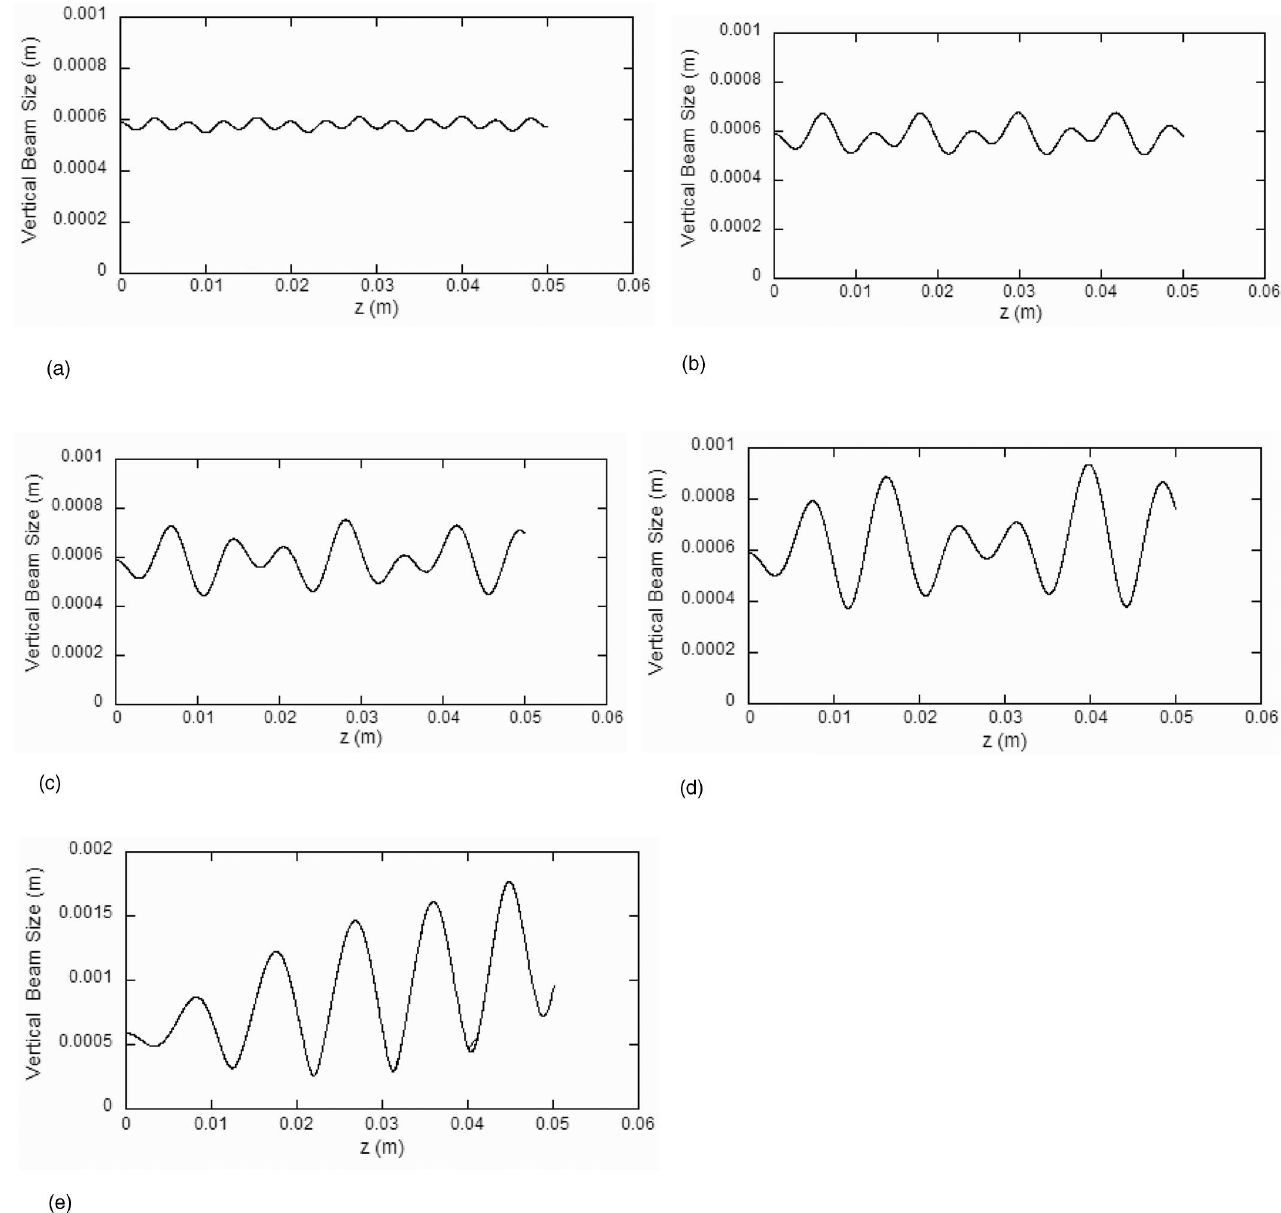
FIG. 12. Vertical beam size for PPM focusing augmented by uniform quadrupole, high-emittance case (a) 8-mm period, (b) 12-mm period, (c) 14-mm period, (d) 16-mm period, and (e) 18-mm